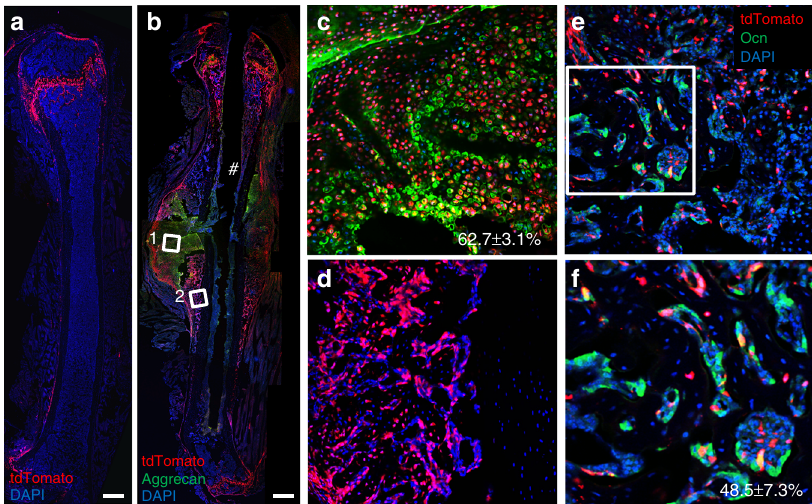
Fig. 7 Gli1 + cells produce chondrocytes and osteoblasts during fracture healing. Gli1-CreER T2 ; Ai9 mice were administered TM at 1 month of age and subjected to fractures 6 weeks later. Mice were harvested at 10 days after fracture. Scale bar: 500 µ m. a Representative confocal image of contralateral (unfractured) femoral sections at the time of harvest. Note relatively little tdTomato signal (red) in periosteum. b – d Representative confocal image of femoral sections through fracture site, with immuno fl uorescence staining of Aggrecan (green) to demarcate chondrocytes. Hash symbol indicates position of pin used for fracture stabilization. Boxed areas of cartilage callus (box 1) and bony region (box 2) are shown at higher magni fi cation in c and d , respectively. Percentage (mean ± SD, n = 3) of tdTomato + Aggrecan + over Aggrecan + cells in c was calculated from three mice (one representative section per mouse). e , f Immuno fl uorescence staining of Ocn on bony callus. Boxed area in e is shown at higher magni fi cation in f . Percentage (mean ± SD, n = 3) of tdTomato + ;Ocn + over Ocn + osteoblasts was calculated from three mice (one representative section per